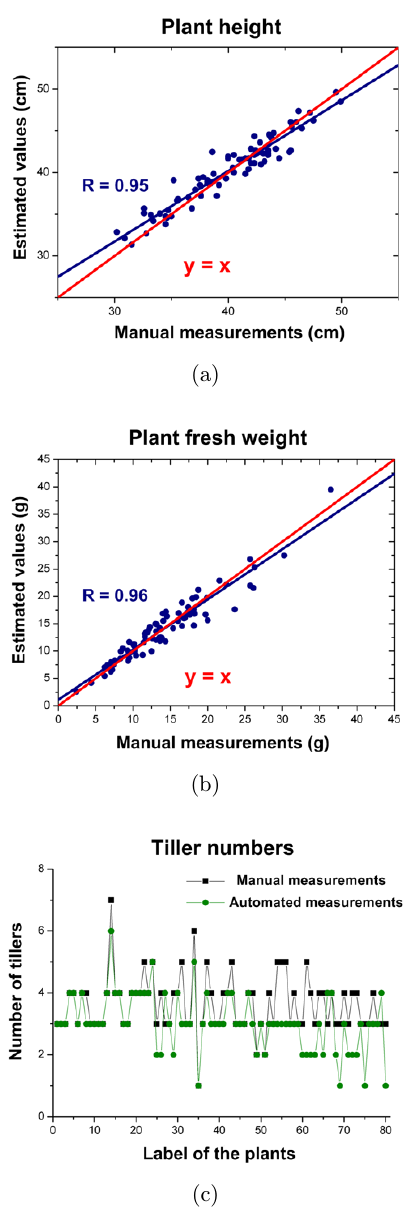
Fig. 8. Scatter plots of the automated and manual measure- ments: (a) plant height, (b) plant fresh weight and (c) number of tillers. In (a) and (b), the regression lines (blue) are drawn for comparison with the y ¼ x line (red). The correlation coe±- cients for the plant height and plant fresh weight are 0.95 and 0.96, respectively. Table 1. Model statistics and estimated parameter values for the plant height and plant fresh weight. H m indicates the manually measured plant height, H c indicates the model height extracted from the 3D model, PFW m indicates the manually measured plant fresh weight, and V c indicates the volume extracted from the 3D model. Model Coe±cient SE R F P MAPE RMSE H m ¼ a (cid:1) H c þ b